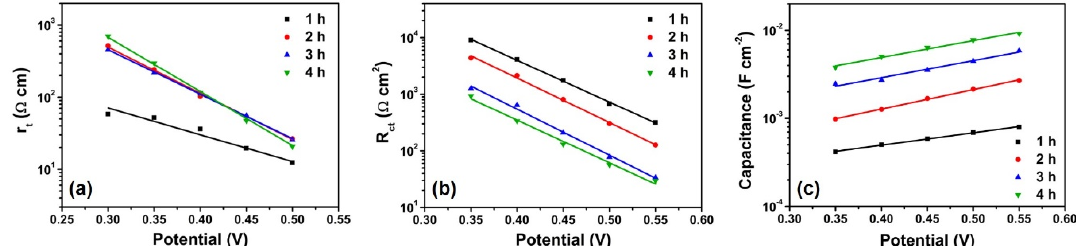
Figure 6. ( a ) Electron transport resistance, ( b ) recombination resistance, and ( c ) chemical capacitance for the anodic TiO 2 NT electrodes depending on the anodization time, evaluated from the impedance spectra. impedance